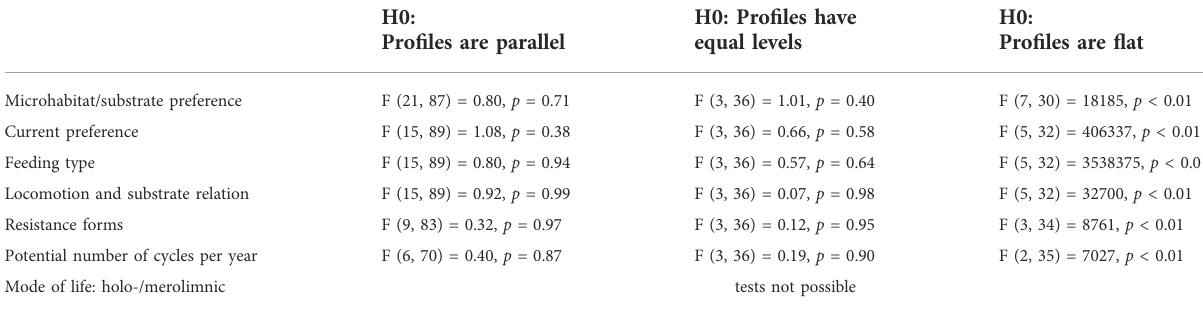
TABLE 2 Report of the pro fi le analysis: for all the tested traits, pro fi les were parallels, with equal levels, not fl at. For further details concerning the analysis, refer to Bulut and Desjardins (2020). (H0 = null hypothesis).